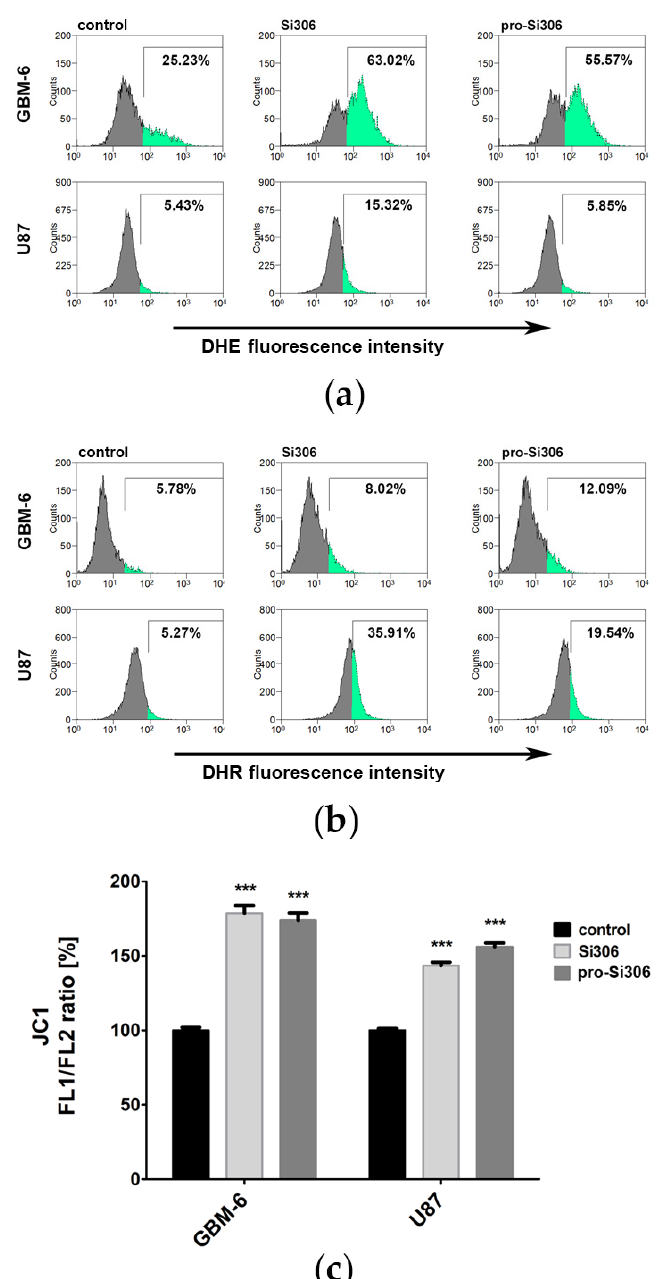
Figure 3. Si306 and pro-Si306 increase the levels of reactive oxygen and nitrogen species and depolarize mitochondrial membrane in glioblastoma cells. DHE, DHR and JC-1 fluorescence was evaluated by flow cytometry after 24 h treatment with 10 µ M Si306 and pro-Si306. ( a ) Production of superoxide anion in GBM-6 and U87 cells. Percentages represent the number of cells with high levels of superoxide anions. The region of interest (green) was set to include approximately 5% of DHE-positive cells in the U87 control group. Due to the greater heterogeneity of GBM-6, the region of interest captured about 25% of DHE-positive control cells. ( b ) Production of hydrogen peroxide and peroxynitrite anion in GBM-6 and U87 cells. Percentages represent the number of cells with high levels of hydrogen peroxide and peroxynitrite anions. The region of interest (green) was set to include approximately 5% of DHR-positive cells in the control group. ( c ) Transmembrane potential of the mitochondrial membrane in GBM-6 and U87 cells. The histogram shows the relative ratio of JC-1 fluorescence in FL1 and FL2 channels. A statistically significant difference between treated and control groups is shown as *** ( p < 0.001).